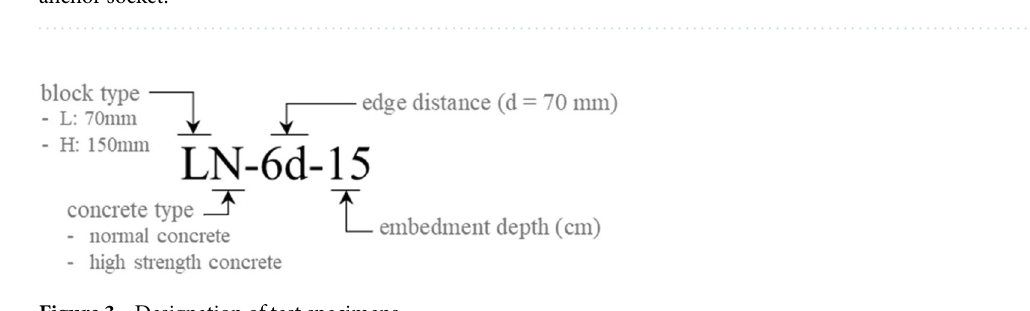
Table 1. Test matrix. a Compressive strength of concrete at test day. b Compressive strength of grout at test day. c Distance from the center of an anchor shaft to the edge of concrete in one direction. d Embedment depth of anchor socket.